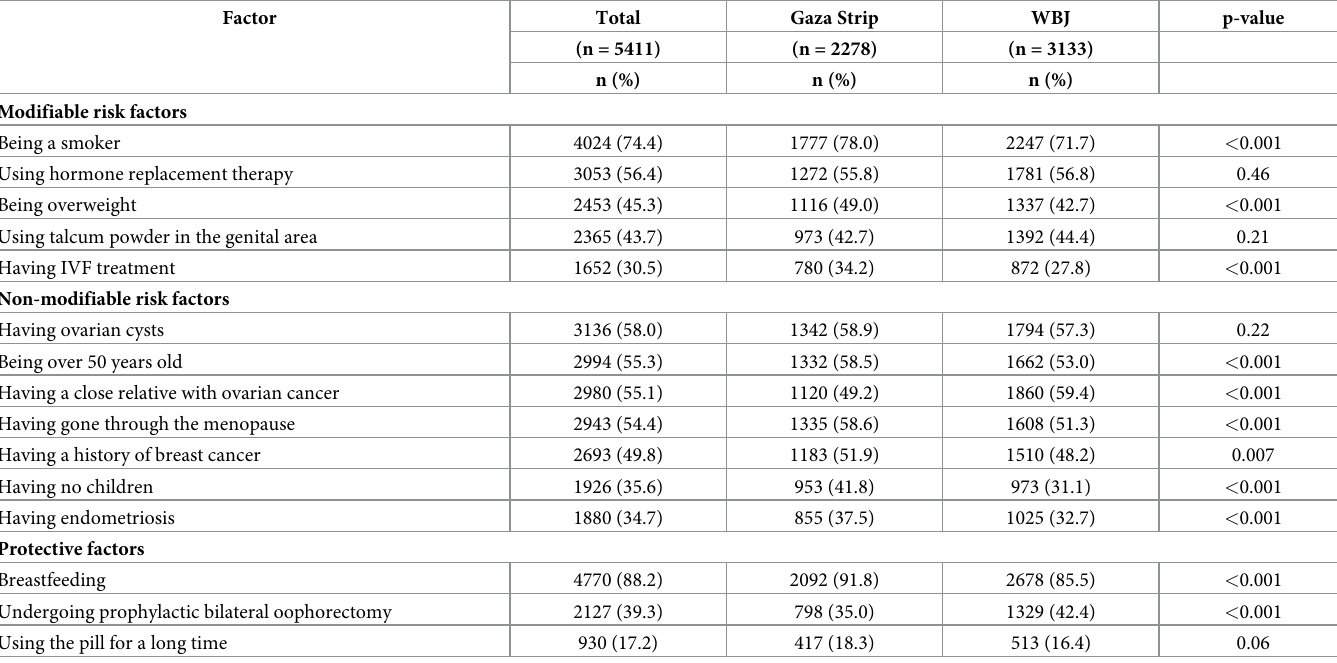
Table 2. Recognition of ovarian cancer risk and protective factors.